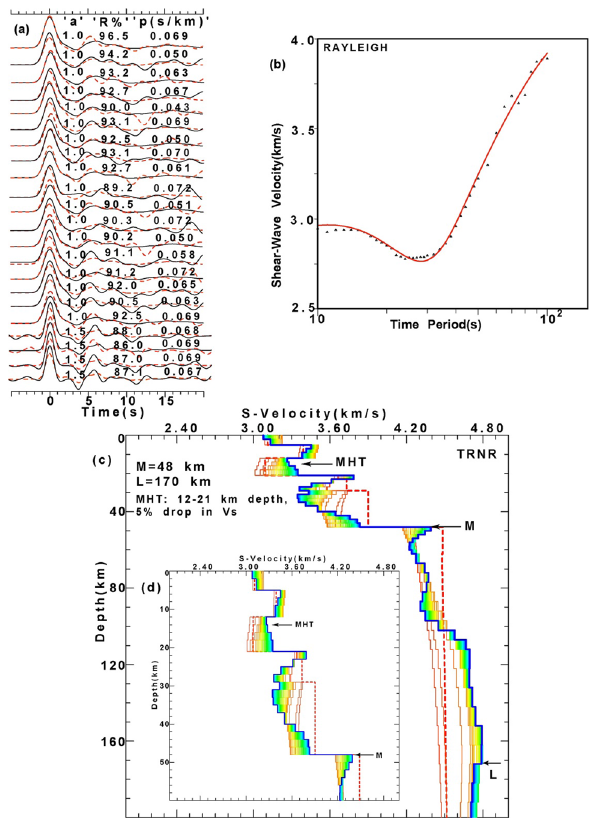
Figure 4. Results of joint inversion of P-RFs and fundamental mode Rayleigh wave group velocity dispersion data at TRNR station, ( a ) showing good agreement between observed (black line) and inverted (red line) radial RFs with a = 1.0 and 1.5, for different horizontal slowness (S, in s/km). Here, “a” and “R%” represent Gaussian width factor (used for estimating RF) and agreement (in %) between observed and inverted RFs, respectively. ( b ) Correlation between observed and inverted dispersion curve of Rayleigh waves. ( c ) Inverted shear velocity models showing Moho (M) and LAB (L) depth estimates. Different colors represent different Versus models used for the joint inversion. The initial shear velocity model is shown by a thick red dotted line, while the final shear velocity model is shown by a thick blue line, and ( d ) zoomed portion of figure ( c ) showing only crustal Versus model. Furthermore, MHT, M, and L mark the thickness of the Main Himalayan Thrust in km, Moho depths in km and lithospheric thickness in km,